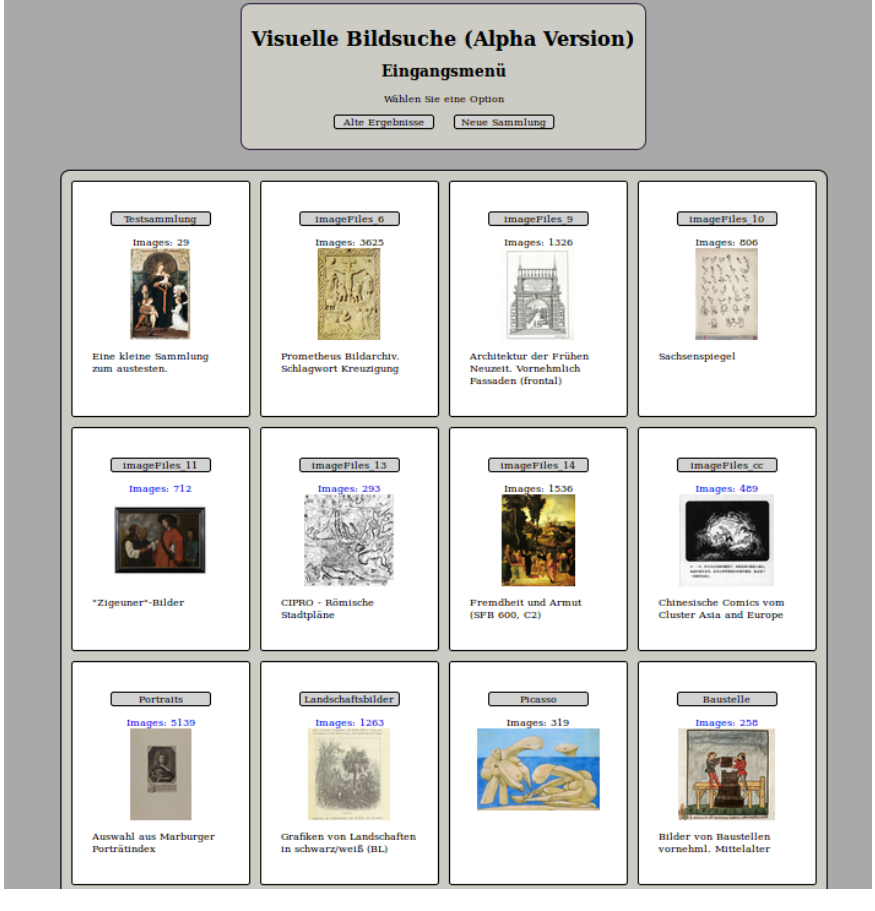
Figure 1. Current image collections on the interface developed by the Computer Vision Group; the first row shows a test set, a collection of art, depicting the Crucifixion, architectural drawings and medieval manuscripts. Image rights: Computer Vision Group, Heidelberg University.